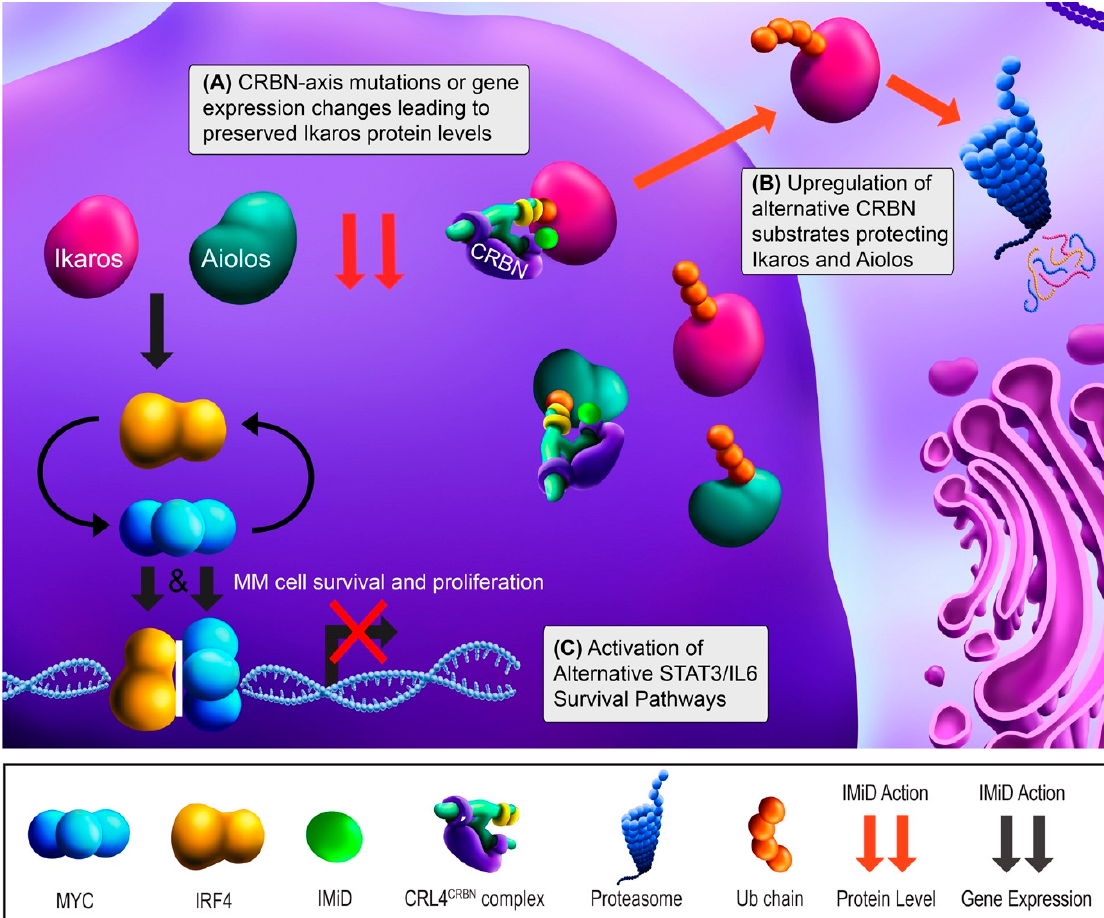
Figure 1. Immunomodulatory drug (IMiD) mechanism of action and resistance mechanisms. Ikaros (IKZF1) and Aiolos (IKZF3) increase the gene expression of IRF4 (yellow) and MYC (cyan), leading to multiple myeloma (MM) cell survival and proliferation. IRF4 and MYC bind to their respective promoters independently, but also upregulate each other’s gene expression. With treatment, IMiD binding leads to the Cereblon (CRBN)-dependent proteasomal degradation of ubiquitin (Ub)-tagged Ikaros and Aiolos (red arrows). IKZF1/3 degradation leads to the downregulation of IRF4 and MYC gene expression (black arrows) and results in growth arrest and apoptosis (red “X”). ( A ) IMiD resistance can occur when components in the CRBN-Ikaros axis are mutated or undergo altered expression, most frequently downregulation of CRBN. ( B ) IMiD resistance can also occur through increased expression of alternative CRBN substrates that effectively prevent IKZF1/3 degradation by binding CRBN or by mediating the CRBN degradation. ( C ) Finally, IMiD resistance can occur via upregulation of alternative survival pathways to bypass Ikaros axis dependence, including IL-6/STAT3